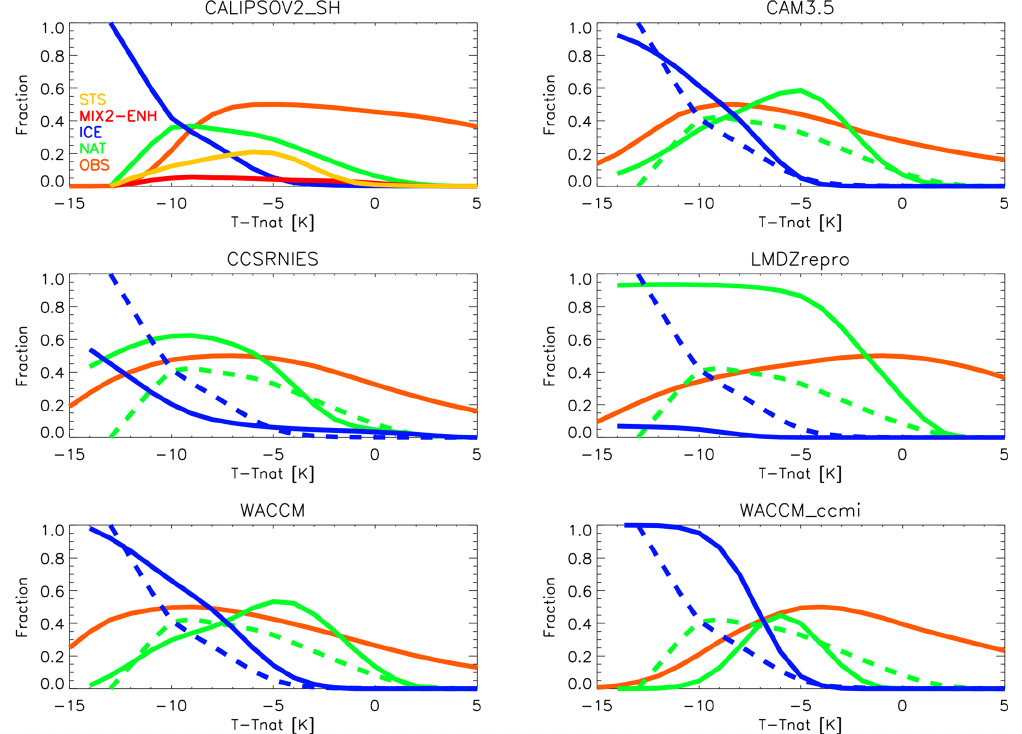
Figure 12. As in Fig. 4 but for 60–82 ◦ S CALIOP v2 observations and CCMs data. CALIOP data are reported as dashed lines on each model as reference. The orange curve (OBS) is a histogram for the temperature distribution of all observations (CALIOP) or simulations